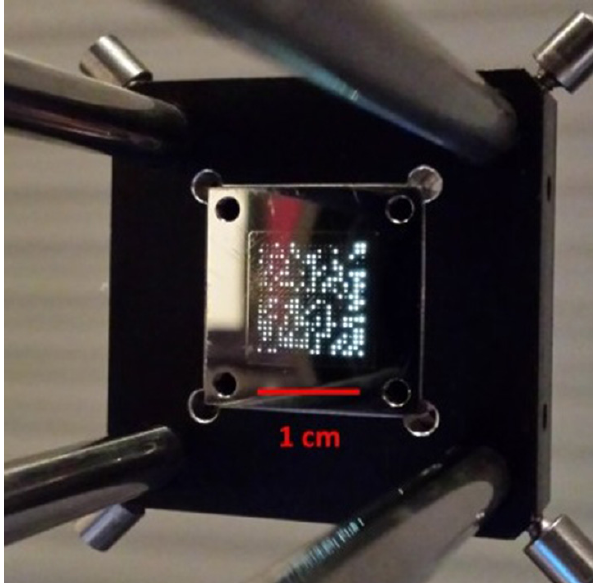
Figure 2. (Reprinted from Schmälzlin et al., 2015): image acquisi- tion head with a 20 × 20 fiber matrix. For demonstration purposes of this picture the fibers are partially illuminated at the distal end of the fiber bundle.